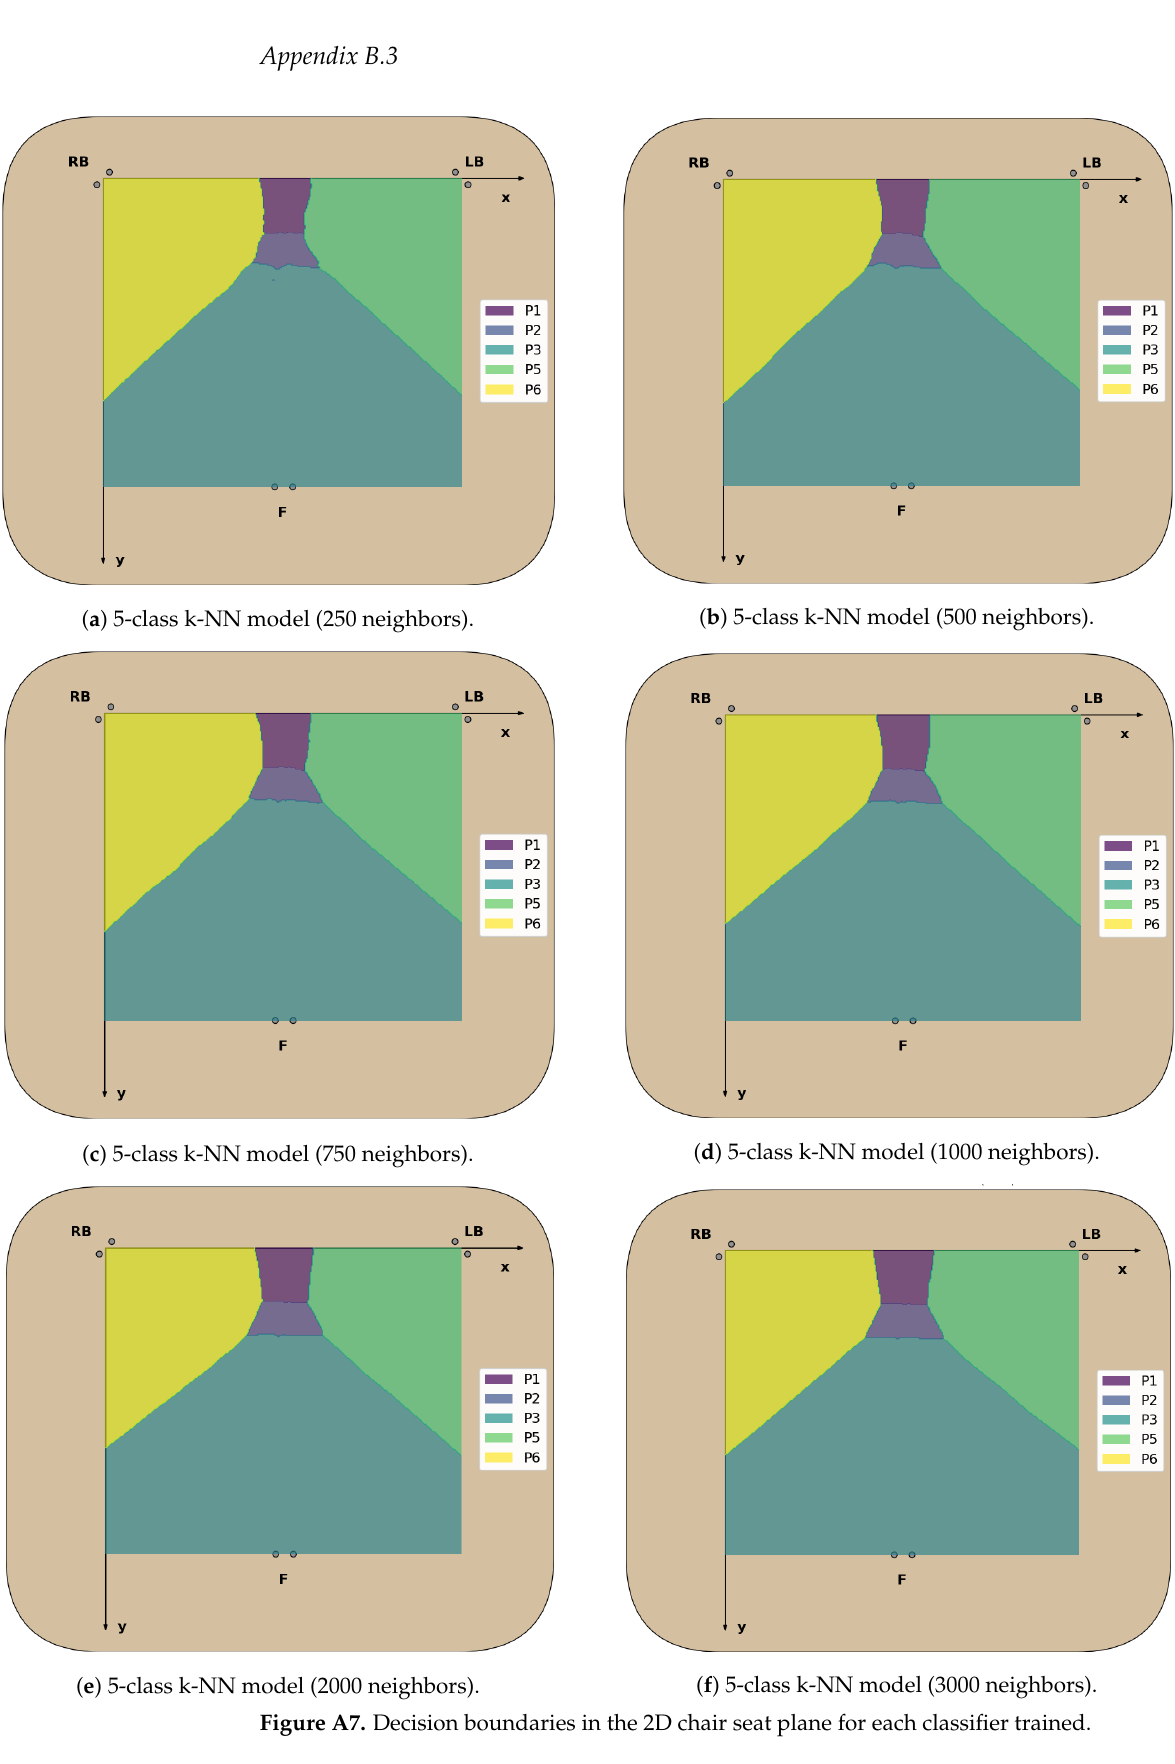
Figure A7. Decision boundaries in the 2D chair seat plane for each classifier